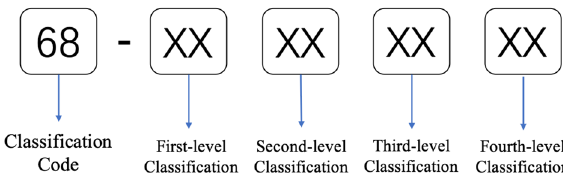
Figure 3. Example format of the code writing principle.